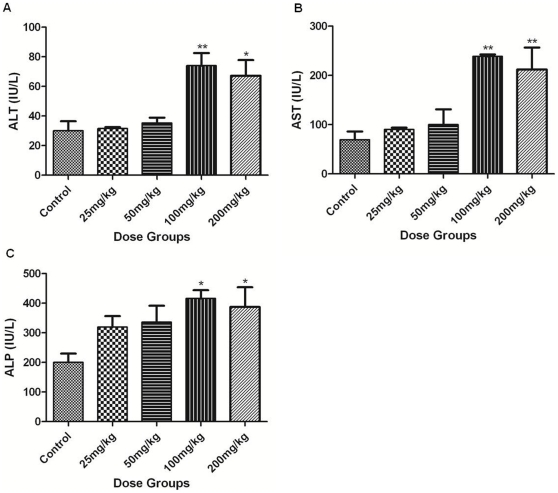
Levels of serum biomarkers of hepatotoxicity.(A) Alanine amino transferase (ALT), (B) Aspartate amino transferase (AST), and (C) Alkaline phosphatase (ALP) levels were estimated in serum following the administration of Apigenin at different doses (Control, 25, 50, 100 and 200 mg/kg). The asterisks indicate significance of differences (*-p<0.05; **-p<0.01; ***-p<0.001) in comparison to control.